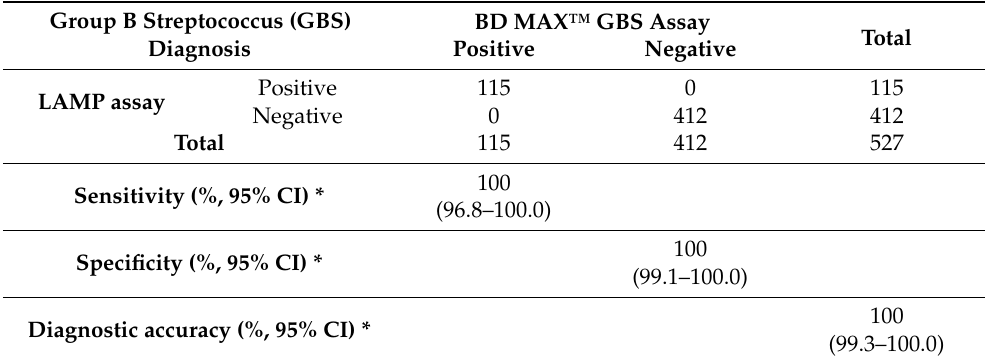
Table 1. Diagnostic performance of Loop-Mediated Isothermal Amplification (LAMP) assays with reference to BD